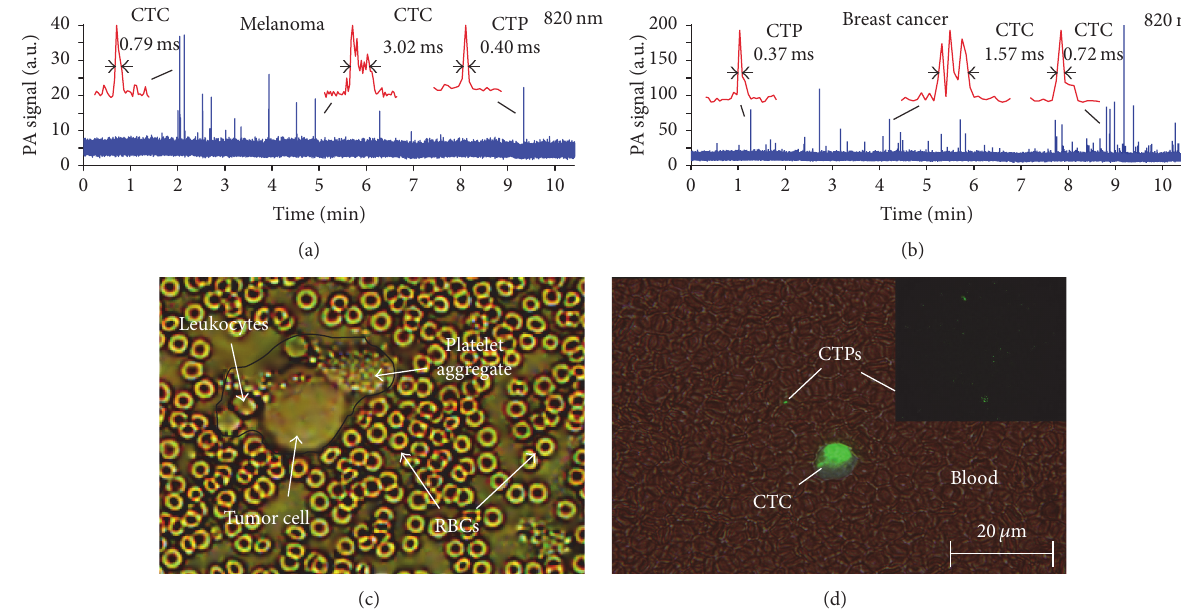
Figure 4: In vivo detection of CTCs and CTPs in tumor-bearing mouse models. (a) PA signal traces for melanoma animal model using B16F10 cells in label-free mode. Insets show typical peak shapes for CTCs and CTPs. (b) PA signal traces for breast cancer model using MDA-MB- 231 cells labeled with conjugated gold nanoparticles. Insets show typical narrow peaks from CTPs and wider peaks from CTCs and/or CTP clusters. (c), (d) Images of CTPs in blood collected from melanoma (c) and breast carcinoma (d) tumor-bearing mice using cells with